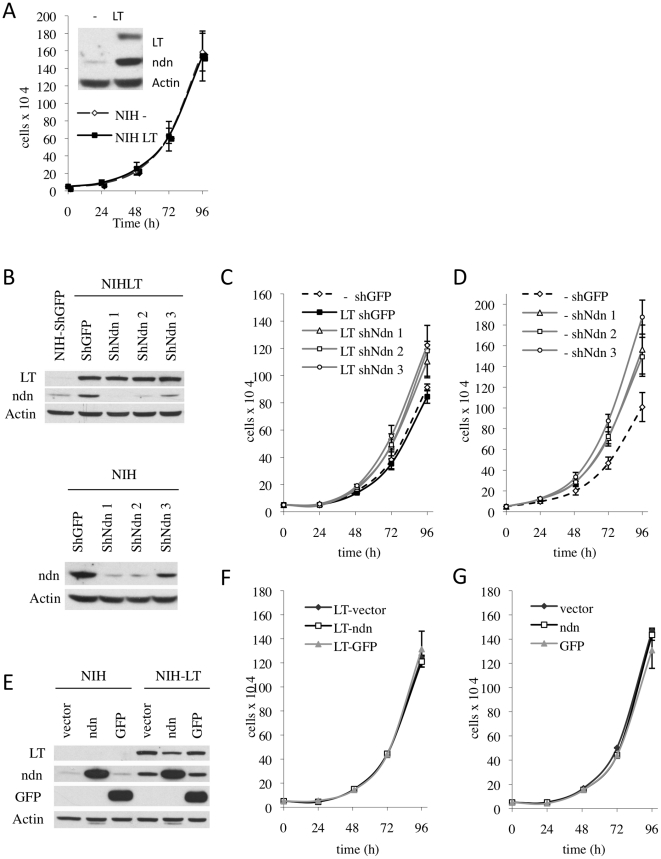
Necdin influences the proliferation of NIH and NIHLT populations.(A) NIH and NIHLT mixed populations proliferate at the same rate. (B) Decrease of Necdin protein levels by three different shRNAs transduced by lentivirus infection in NIHLT and NIH. Growth curves for NIHLT (C) and NIH (D) revealed that cells depleted in Necdin proliferate faster. (E) Protein expression level in NIHLT and NIH cells with overexpression of mouse Necdin, the GFP control or vector alone. Growth curves for NIHLT (F) and NIH (G) expressing exogenous Necdin after a certain period of time did not shown differences in their growth rate.